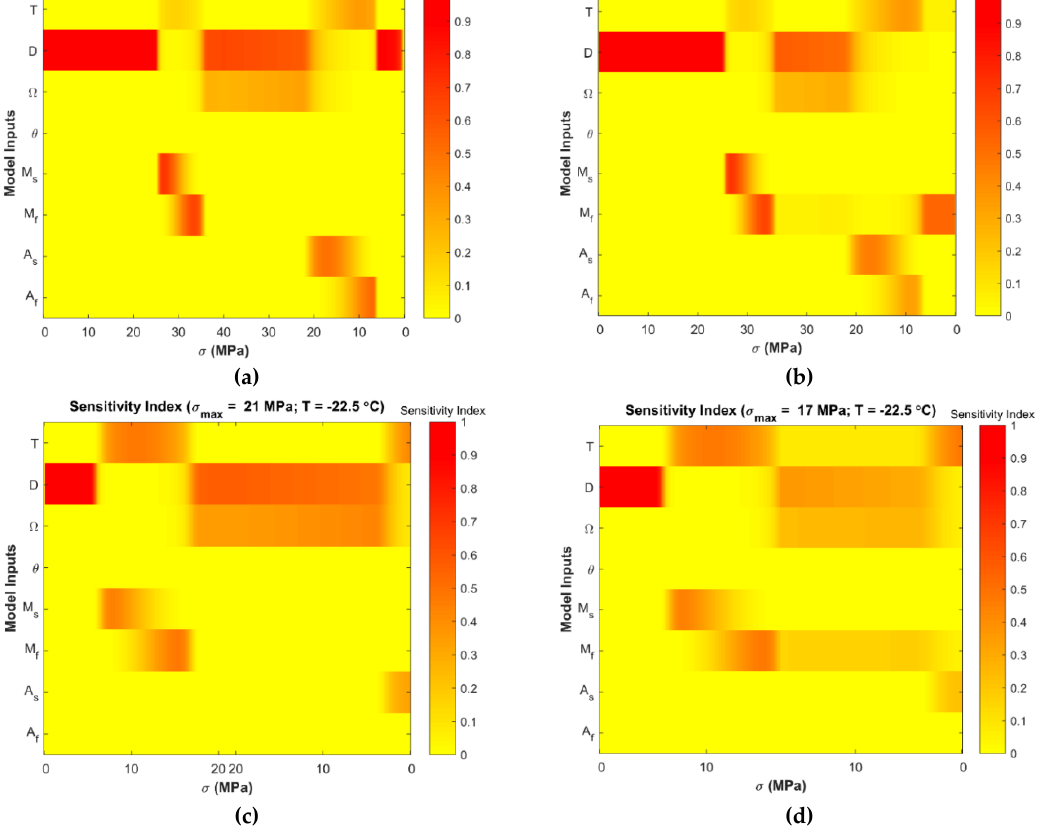
Figure 8. eFAST stress-dependent sensitivity index distribution at simulated temperatures for the Liang-Rogers model (the corresponding stress values during loading and unloading are shown in horizontal axis and inputs are shown in vertical axis): ( a ) T = − 10 ◦ C, σ max = 40 MPa; ( b ) T = − 10 ◦ C, σ max = 36 MPa; ( c ) T = − 22.5 ◦ C, σ max = 21 MPa; ( d ) T = − 22.5 ◦ C, σ max = 17 MPa.